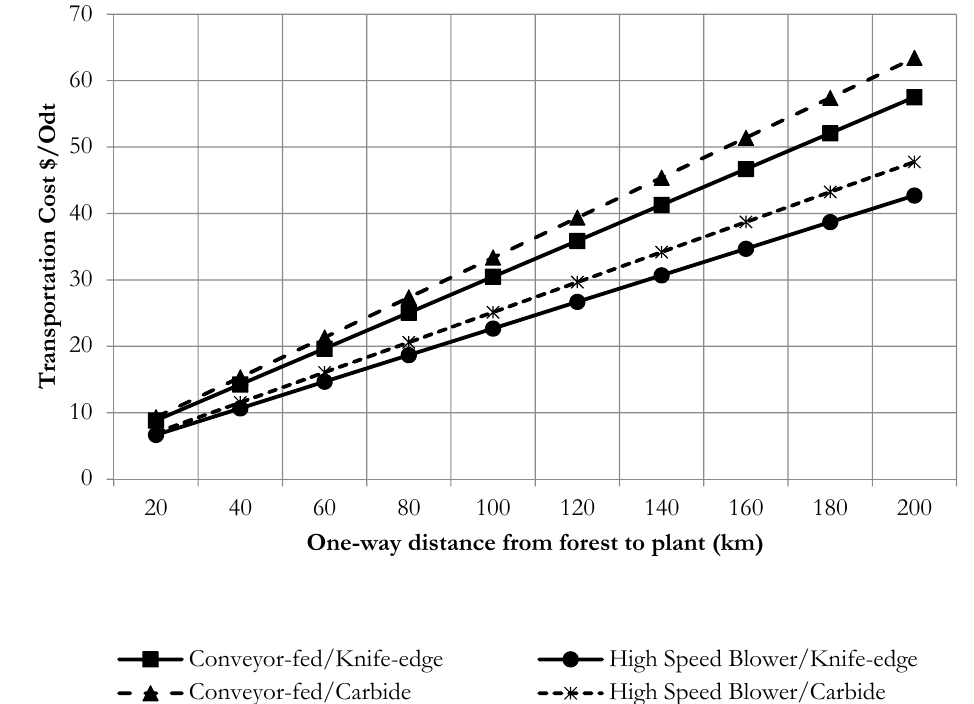
Figure 1. Transportation cost for each of the two loading methods (conveyer-fed by gravity and blowing chips into a container) on pulpwood size class residue. A combination of knife-edge bits and blower loading increased the bulk density of loads, resulting in $14.70/Odt for hauling pulpwood type materials on a 200 km one-way trip. Source: Zamora et al. 2014 [23]